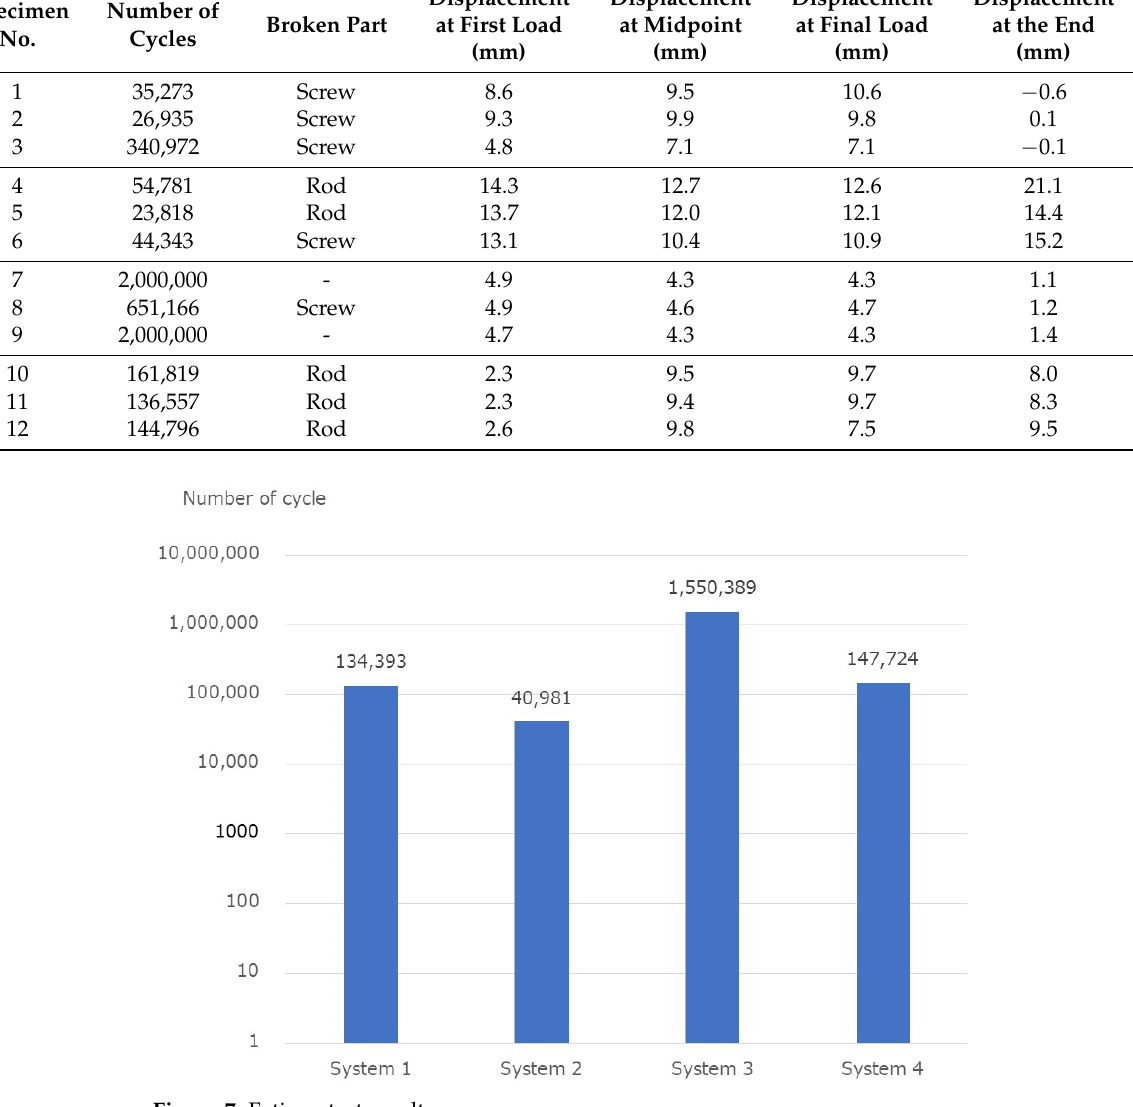
Figure 7. Fatigue test results.